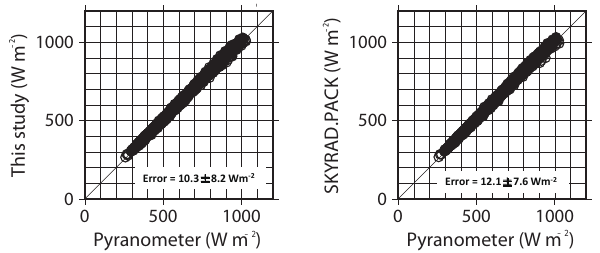
Figure 22. Comparisons of the surface solar irradiance calcu- lated from the SKYLIDAR (left) and SKYRAD.PACK (right) re- trievals with the pyranometer measurements during 2012 and 2013 in Tsukuba,